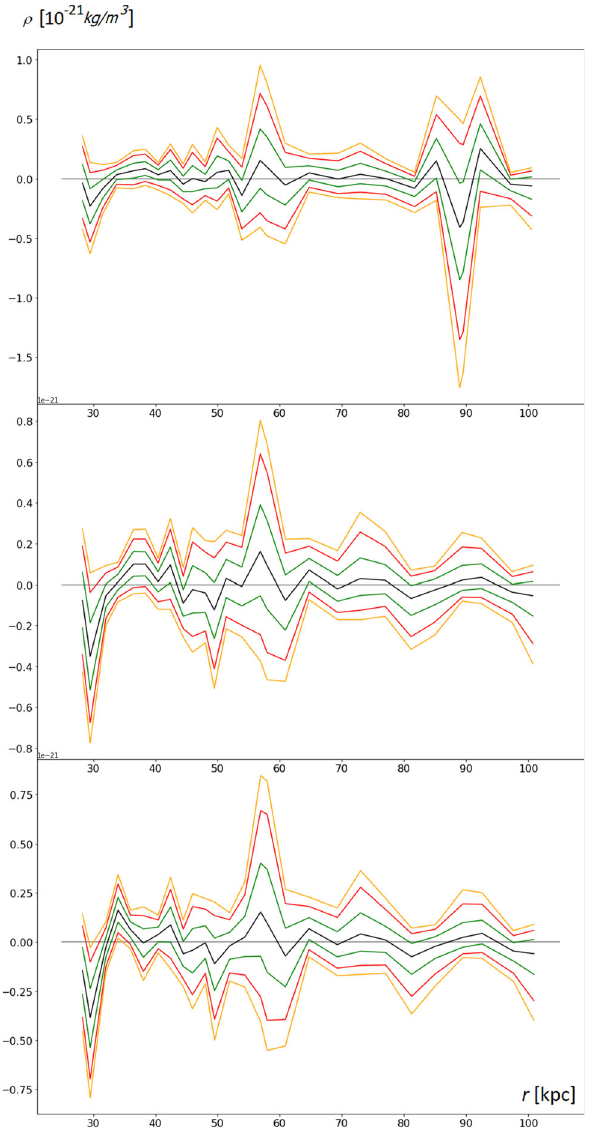
Fig. 4 Median (blackline)andlowerandupperboundsof68% (green lines),95% (redlines)and99% (orangelines)confidenceintervalsof ρ calculated using five-point scheme for the calculation of derivatives for three combinations of distance of Sun from the galactic center and Sun orbital velocity around the galactic center: ( R 0 = 8 . 0 kpc, v 0 = 200 km/s) (top), ( R 0 = 8 . 3 kpc, v 0 = 244 km/s) (middle) and ( R 0 = 8 . 5 kpc, v 0 = 220 km/s) (bottom). Even though it was declared that we have confined the analysis to radial distances above 28 kpc, a few points belowthislimitaredrawninthesegraphsinordertoshowthedownward trend of ρ at lower radii